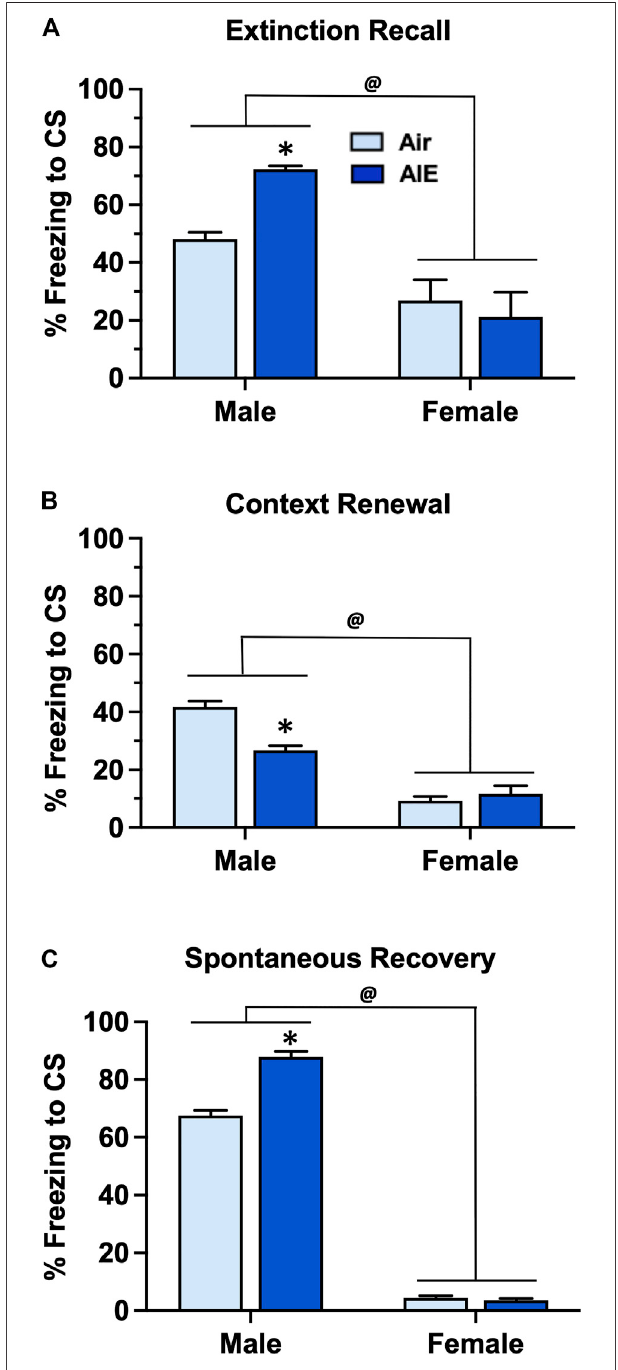
FIGURE 5 | testing of recall, male and female rats were tested for contextual fear renewal by assessing freezing behavior in response to re-exposure to the original conditioning context. Female rats exhibited signi fi cantly lower levels of freezing in response to re-exposure to the conditioning context compared to male rats. AIE exposed male rats also exhibited signi fi cant decreases in context-dependentfreezingcompared tothe maleAircontrolrats.AIE had